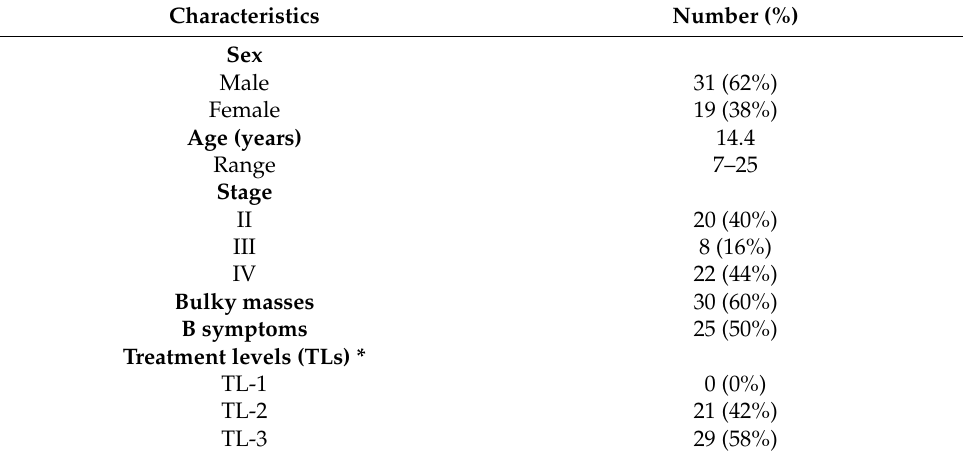
Table 1. Principal characteristics of the study population.